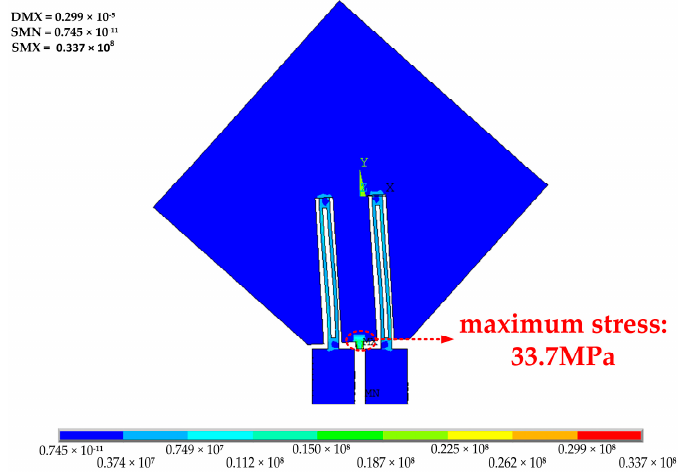
Figure 6. The maximum stress in flexure hinge under 100 g acceleration.